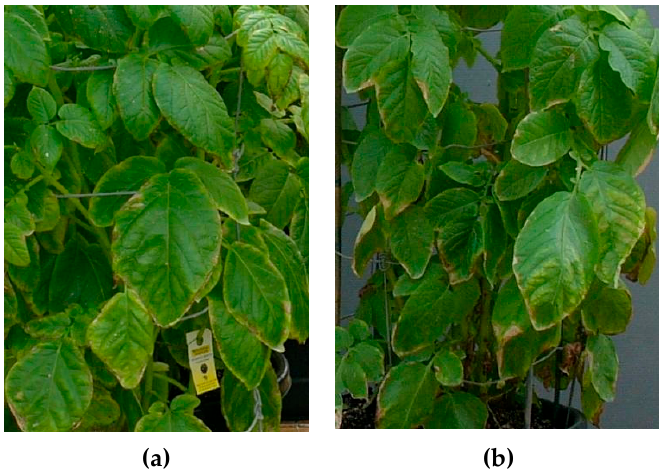
Figure 2. The appearance of the canopies in SALT + 7.5%F at 65 DAP ( a ) and in CONT at 103 DAP ( b